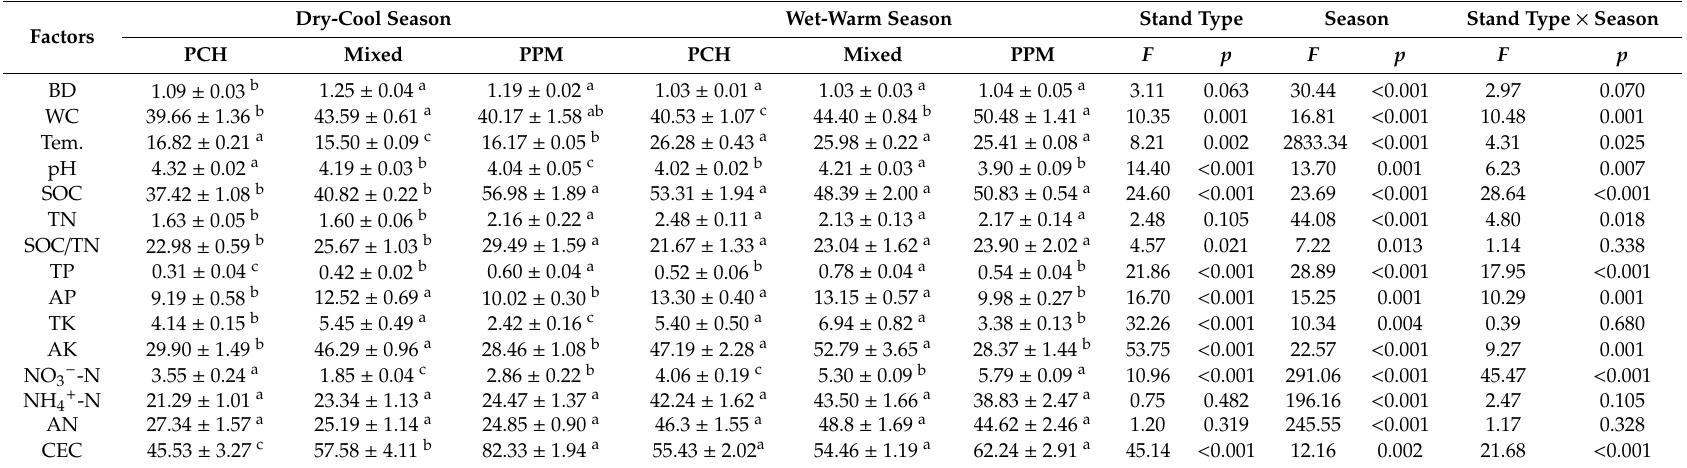
Table 3. Soil physical and chemical properties (0–10 cm soil depth) in pure Castanopsis hystrix (PCH) plantation, pure Pinus massoniana (PPM) plantation, and mixed C. hystrix and P. massoniana (MIX) plantation (mean ± standard error; n =